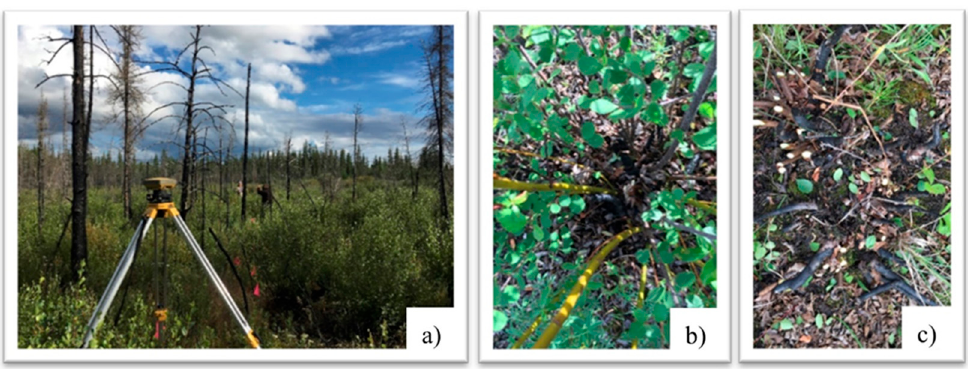
Figure 2. ( a ) Example of a transect traversing a burned upland forest into peatland (fire year 2015); ( b , c ) illustration of a Betula glandulosa shrub individual growing along the transect before and after destructive sampling, respectively.